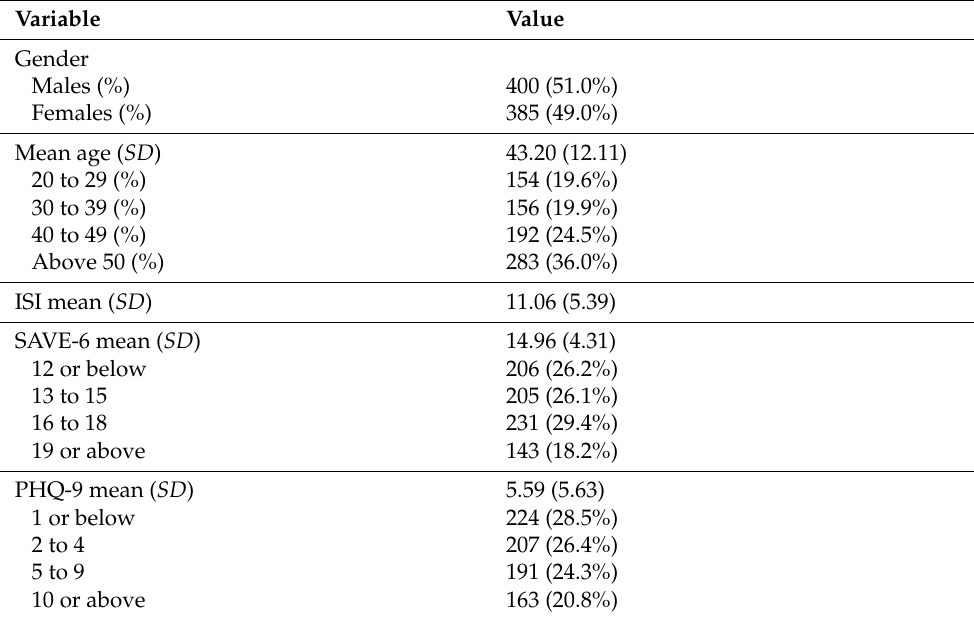
Table 1. Table showing gender ratio, means, and standard deviations of ISI, SAVE-6, and PHQ-9, and number of participants in scale